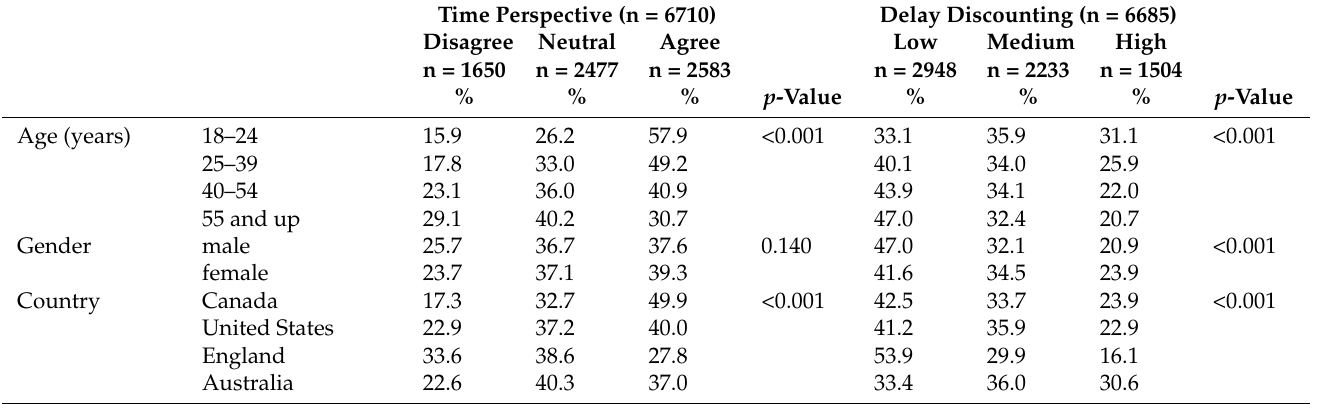
Table A1. Bivariate associations of time perspective and delay discounting with